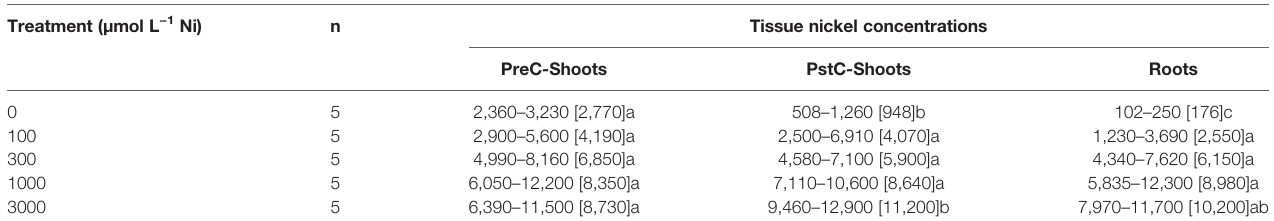
Letters indicate signi fi cant difference between tissues for each treatment, at 5% level (Waller-Duncan k-ratio t-test). All values in in µg g − 1 dry